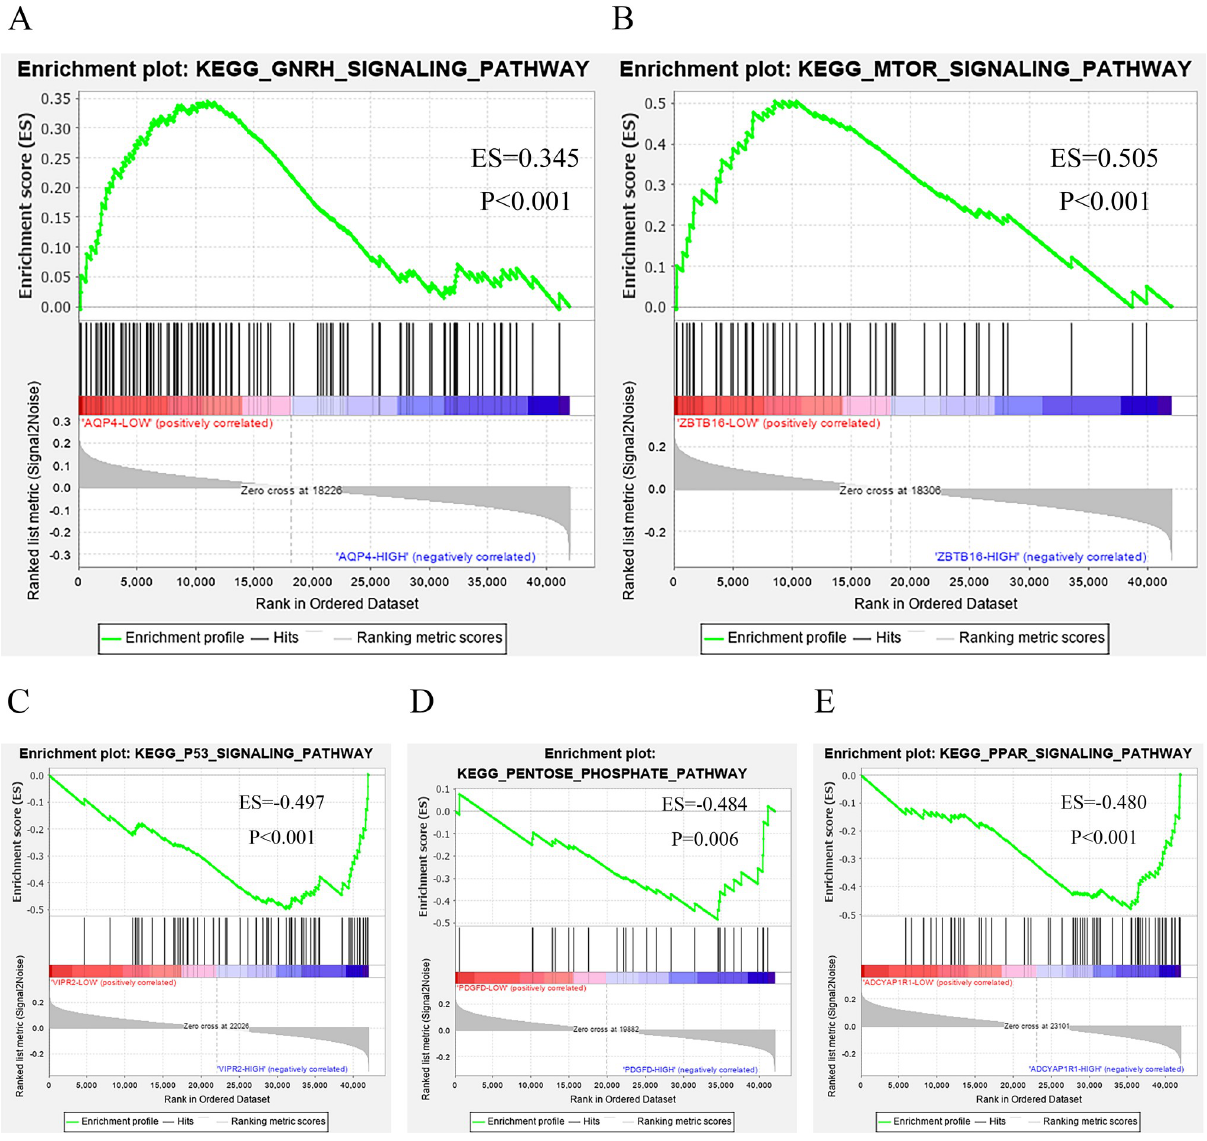
Fig 5. GSEA enrichment curves for ZBTB16, AQP4, ADCYAP1R1, PDGFD and VIPR2. (A-E) GSEA enrichment curves for AQP4, ZBTB16, VIPR2, PDGFD and ADCYAP1R1 based on gene-high and low expression groups using GSEA software, respectively. Where ES denotes Enrichment Score and p denotes Nominal p-value. (A) AQP4 probably through the GNRH signaling pathway, (B) ZBTB16 probably through the MTOR signaling pathway, (C) VIPR2 probably through the P53 signaling pathway, (D) PDGFD probably through the PENTOSE- PHOSPHATE signaling pathway and (E) ADCYAP1R1 may play a role in the prognosis of esophageal cancer through the PPAR signaling pathway.